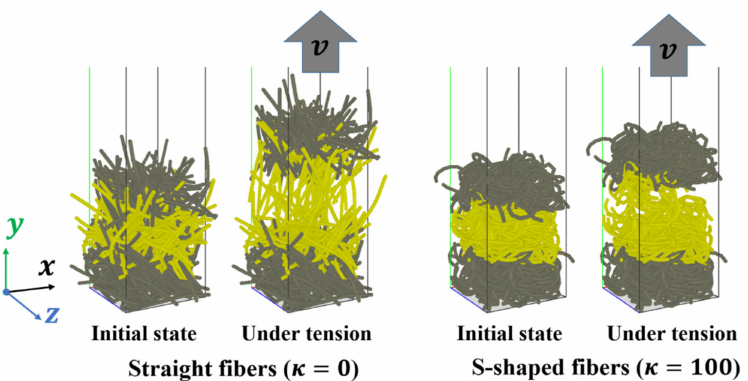
Figure 12. Numerical models of tensile tests.